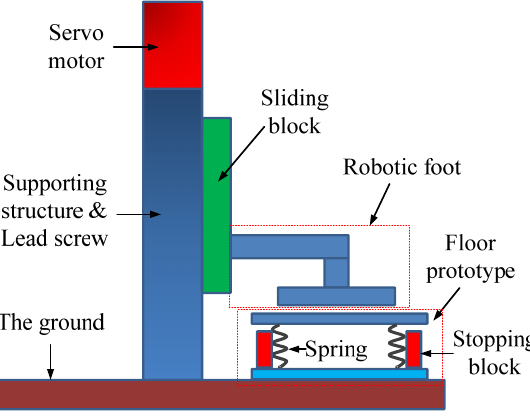
Figure 5. Structure of the stepping machine (side view).